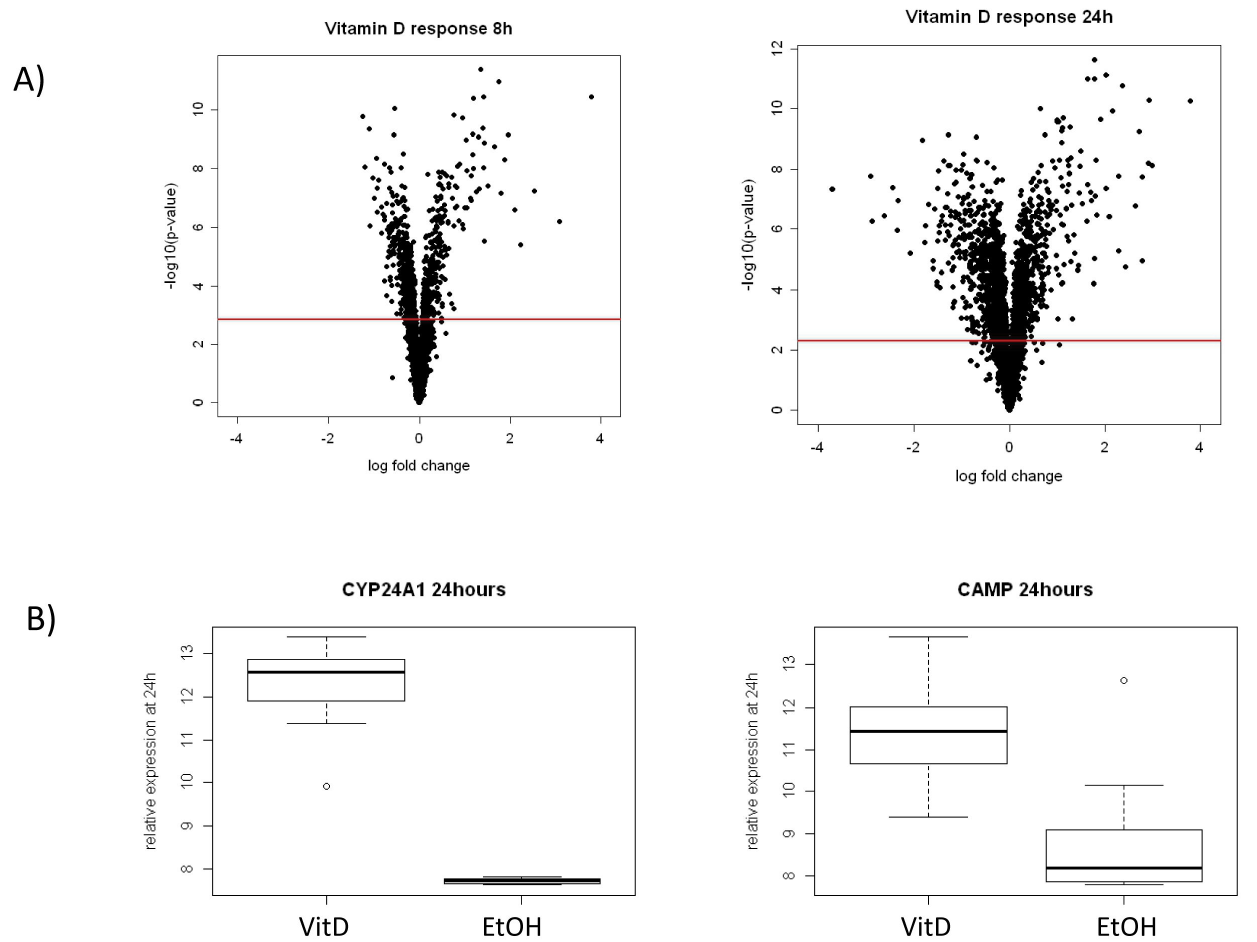
Figure 2. Transcriptional response to vitamin D overall and for specific vitamin D responsive genes. ( a ) Volcano plot of transcriptional response to vitamin D at 8 hours and 24 hours respectively summarizing mean log fold change (vitamin D/vehicle) 2 and corresponding evidence of differential expression (-log p-value) for each gene shown as a single point. The red line 10 corresponds to an FDR of 1%. ( b ) Boxplots showing examples of two established vitamin D responsive genes at 24 hours including CYP24A1 and CAMP . CYP24A1 encodes 1,25-dihydroxyvitamin D 24-hydroxylase, a member of the cytochrome P450 superfamily, that initiates degradation of 1,25 vitamin D and had the largest response to vitamin D treatment (log fold change 4.54, p-value=2.40 2 x 10 -9 ). CAMP , cathelicidin anti-microbial peptide, is a known target of the vitamin D receptor and also showed a large response to treatment (log fold change 2.62, p-value=1.64 x 10 -7 ). 2 doi: 10.1371/journal.pone.0076643.g002 ADORA3 4.31 vs. -0.66, respectively and ZCCHC12 3.51 vs. 0.27, respectively).